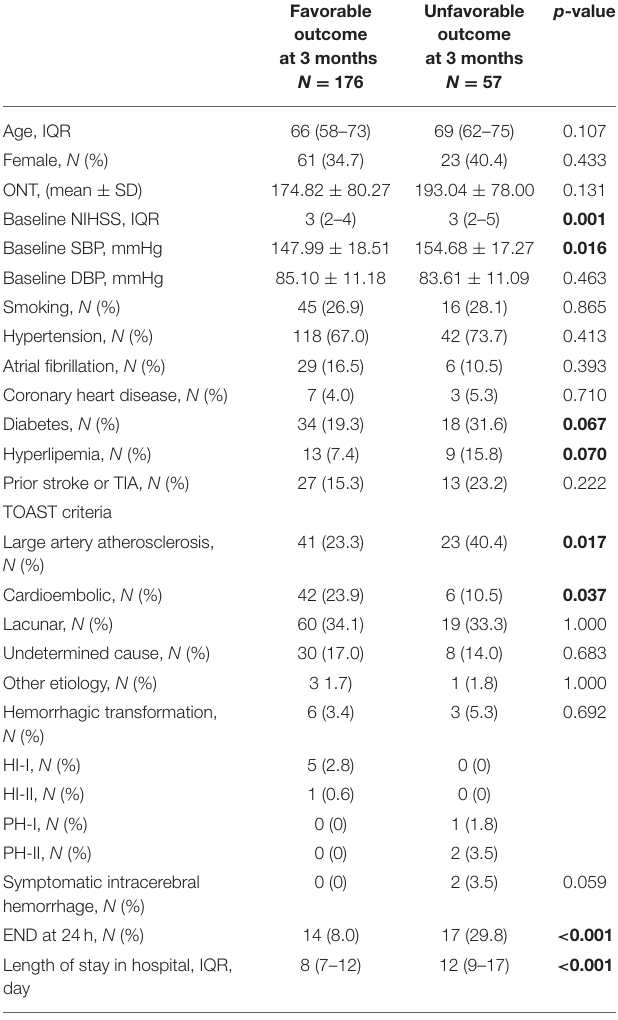
TABLE 3 | Characteristics of mild acute ischemic stroke patients with IVT with or without favorable outcomes at 3 months.